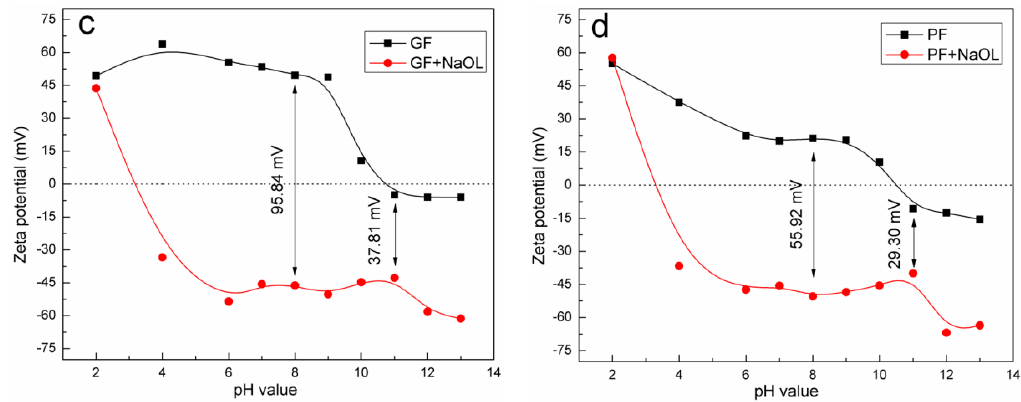
Figure 8. Zeta potentials of fluorites ( a ) in the absence of NaOL; and ( b ) CF; ( c ) GF; and ( d ) PF in the presence of NaOL, as a function of solution pH.